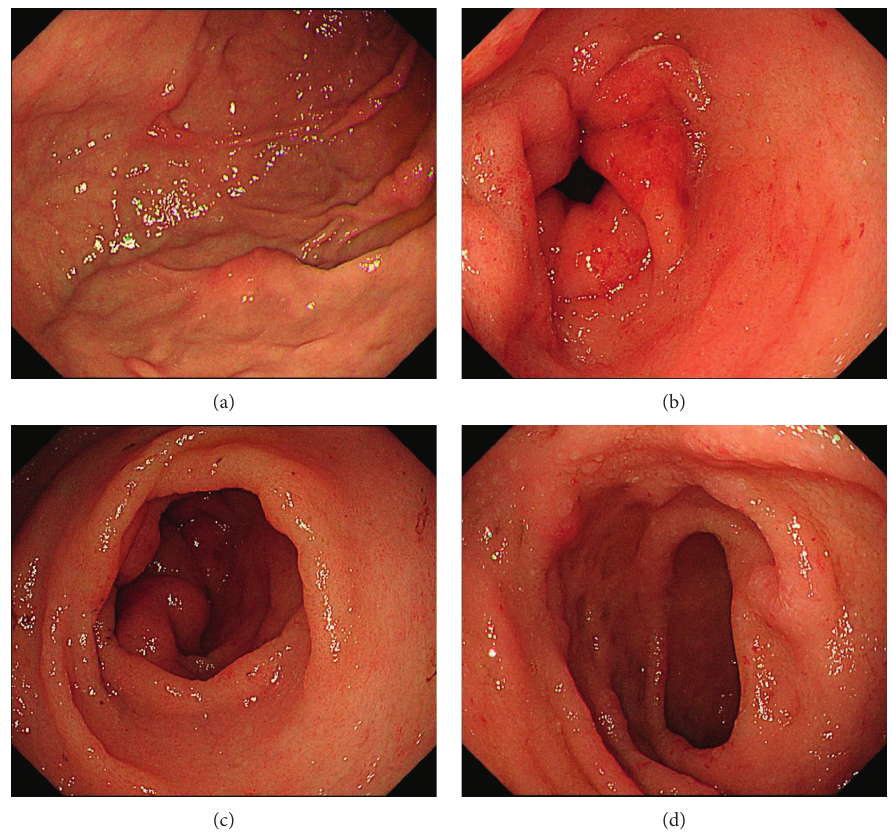
Figure 2: Findings of esophagogastroduodenoscopy (EGD). EGD revealed some elevated lesions in the gastric fornix (a) and moderate edema with redness in the gastric antrum and duodenum